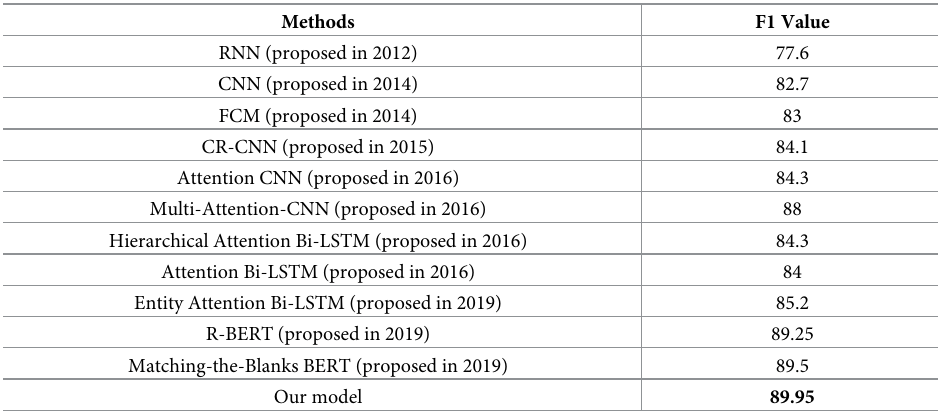
Table 9. The comparison of results of different